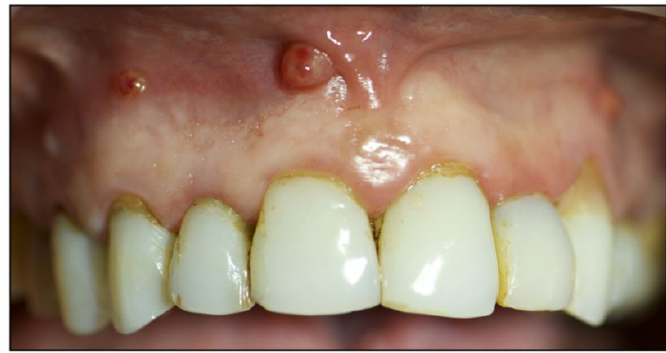
Figure 1. Intraoral preoperative examination .